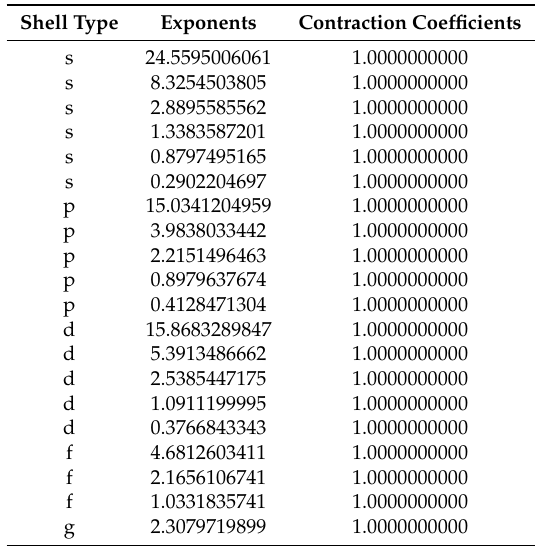
Table A23. Parameters of the cc-TZVP auxiliary basis set of Oxygen. Parameters taken from [89].